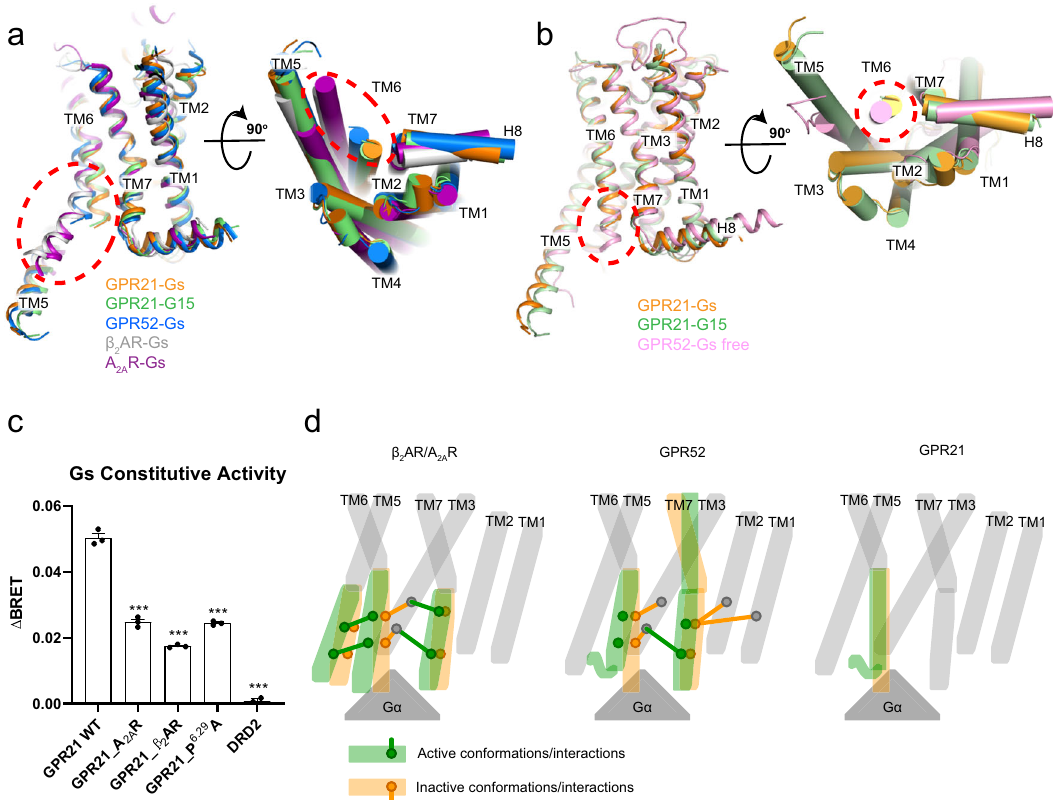
Fig. 4 | Active conformation of GPR21. a Superposition of GPR21-Gs, GPR21-G15, GPR52-Gs (PDB: 6LI3), β 2 AR-Gs (PDB: 3SN6) and A 2A R-Gs (PDB: 5G53) structures. b Superposition of GPR21-Gs, GPR21-G15 and Gs-free GPR52 (PDB: 6LI1) structures. c Constitutive activities of WT GPR21 and GPR21 chimera receptors measured by BRETassay(see “ Methods ” )(GPR21_A 2A R,replacingresiduesQ235 ICL3 -V253 6.36 ofWT GPR21 with residues E212 5.73 -L241 6.43 of A 2A R. GPR21_ β 2 AR, replacing residues S233 ICL3 -A251 6.34 ofWTGPR21withH241 ICL3 -L272 6.34 of β 2 AR.GPR21_P 6.29